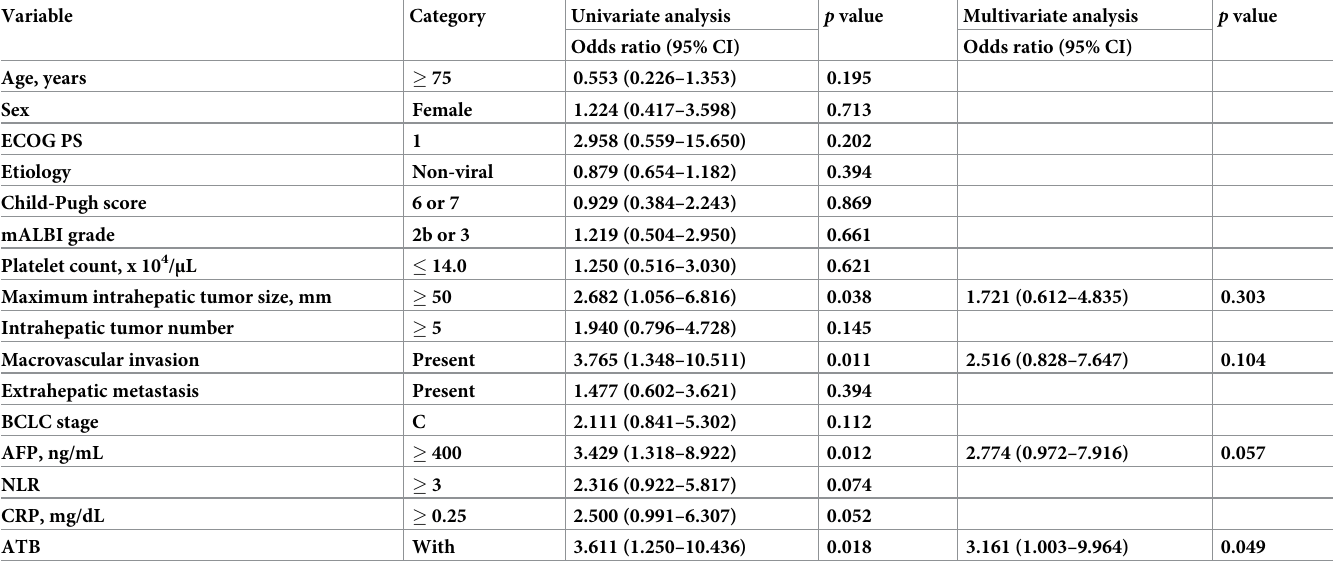
Table 3. Univariate and multivariate analyses of factors associated with progressive disease according to